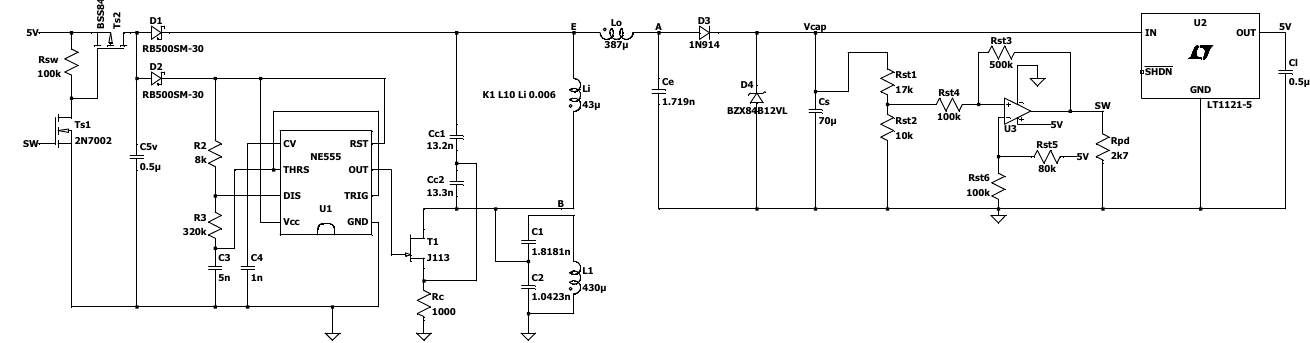
Figure 9. Simulated transmitter circuit inductively coupled to the class-E amplifier circuit from [10], which is not depicted in this picture.